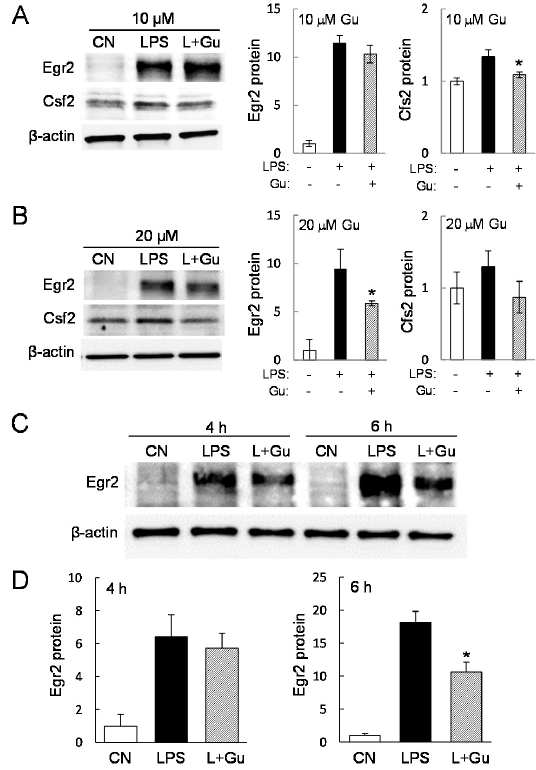
Figure 4. Alterations in the levels of Egr2 protein and Csf2 protein in response to guanabenz. The single asterisk indicates p < 0.05. ( A , B ) Egr2 and Csf2 protein levels in LPS-stimulated RAW264.7 cells in response to 10 and 20 µM guanabenz for 6 h, respectively; ( C , D ) Egr2 and Csf2 protein levels in LPS-stimulated primary macrophages in response to 10 µM guanabenz for 4 and 6 h.